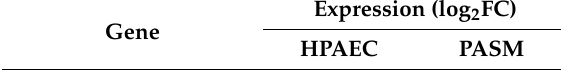
Table 1. Expression of mRNAs of glycosaminoglycan (GAG)-degrading enzymes involved in DS metabolism in human pulmonary artery endothelial (HPAEC) and PASM cells upon ARSB gene silencing. Expression of arylsulfatase B ( ARSB ) was decreased in both HPAEC and PASM cells with similar efficiency. Data from microarrays experiments are shown as the change between expression in cells transfected with siARSB and non-targeting siRNA. Genes with significantly different expression are marked with an asterisk.